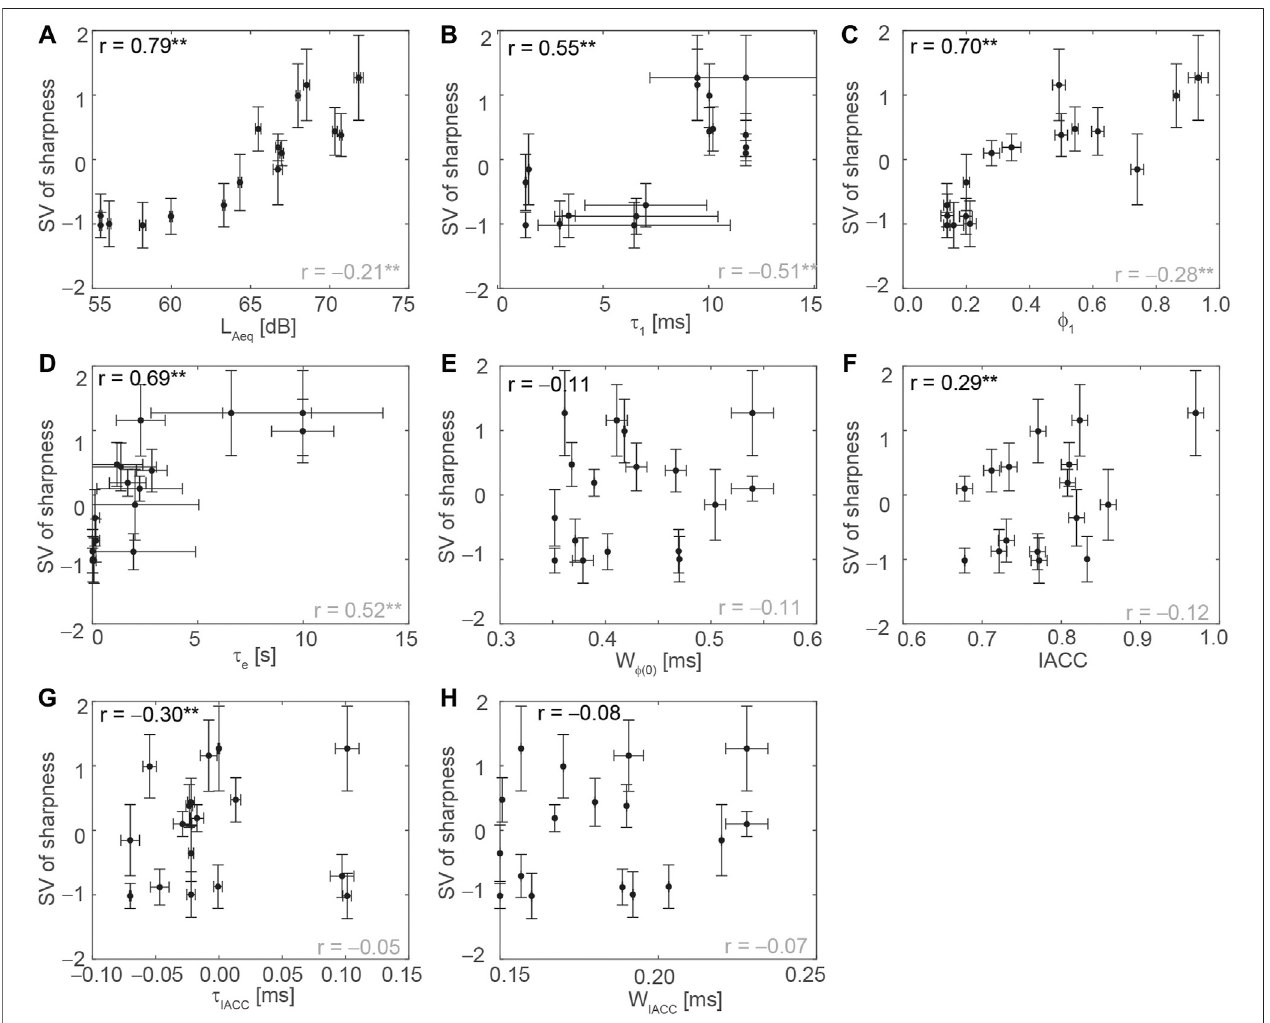
FIGURE 7 | Relationship between correlation parameters and the scale values of sharpness. (A) L Aeq , (B) τ 1 , (C) ϕ 1 , (D) τ e , (E) W ϕ (0) , (F) IACC, (G) τ IACC , and (H) W IACC . The symbols indicate the mean values and the error bars indicate the SDs. The correlation coef fi cients of the mean and SDs are shown in black and gray, respectively. Asterisks represent the level of signi fi cance, i.e., ** p < 0.01, * p < 0.05.